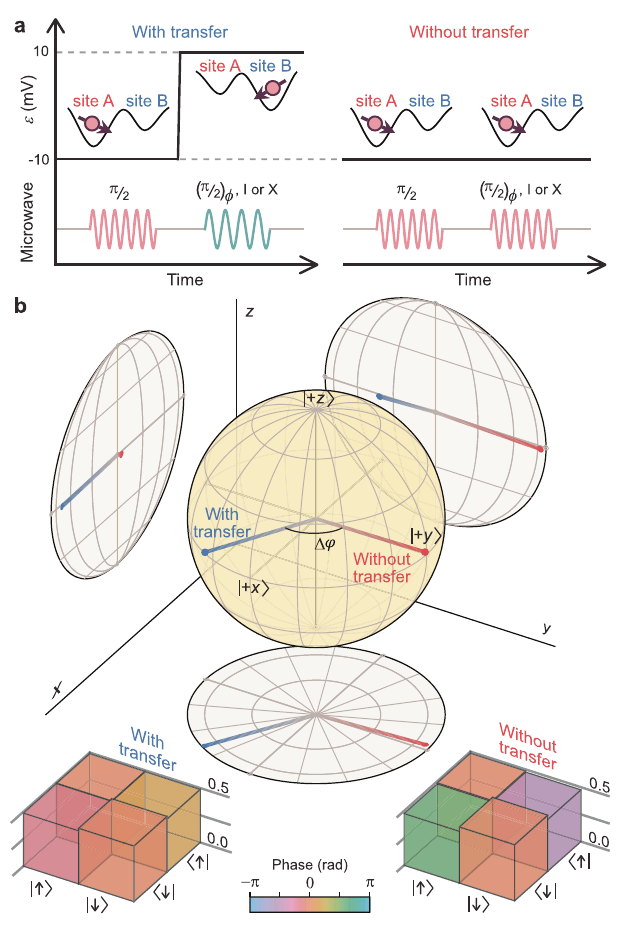
Fig. 3 Quantum tomography of spin states with and without transfer. a Schematic representation of the quantum state tomography experiments. ð π = 2 Þ π /2 ESR rotation along an axis within the xy plane whose ϕ denotes a azimuth angle from the x axis is ϕ . The fi rst eight multiples of π /4 are used for ϕ . I and X represent an identity and a π rotation along x , respectively. b Bloch sphere representation of reconstructed spin states before (red) and after (blue) an inter-site transfer process. The projections onto the xy - (bottom), yz - (right), and zx - (left) planes are also displayed. The primary net effect of the transfer process is the phase shift Δ φ , rooted in the site- dependence of qubit frequency. The insets show the amplitude (height) and phase (color) of the density matrix elements for The coherence loss extracted above is a combination of the temporal dephasing of a freely precessing spin and the errors introduced by the transfer process. This is because the phase evolution time T evol increases by 56 ns per transfer in the above protocol and the temporal dephasing rate for a T 2 * = 20 μ s could be 0.3%. Instead, we can estimate the error induced by the transfer process only, by using a slightly modi fi ed sequence in which T evol is fi xed as n is increased. The fringe decay rate (orange data in Fig. 4c) yields a coherence loss due to the transfer )%. A similar value of p = (1 : 88 þ 0 : 17 (cid:2) )% is process, p = (1 : 80 þ 0 : 17 (cid:2) 0 : 16 0 : 16 obtained for data where a different fi xed value of the phase evolution time is used, see red data in Fig. 4c. The poorer of the two corresponds to a transfer fi delity of (99 : 36 ± 0 : 05)%, expressed in terms of an average gate fi delity of the transfer process (see “ Methods ” section).